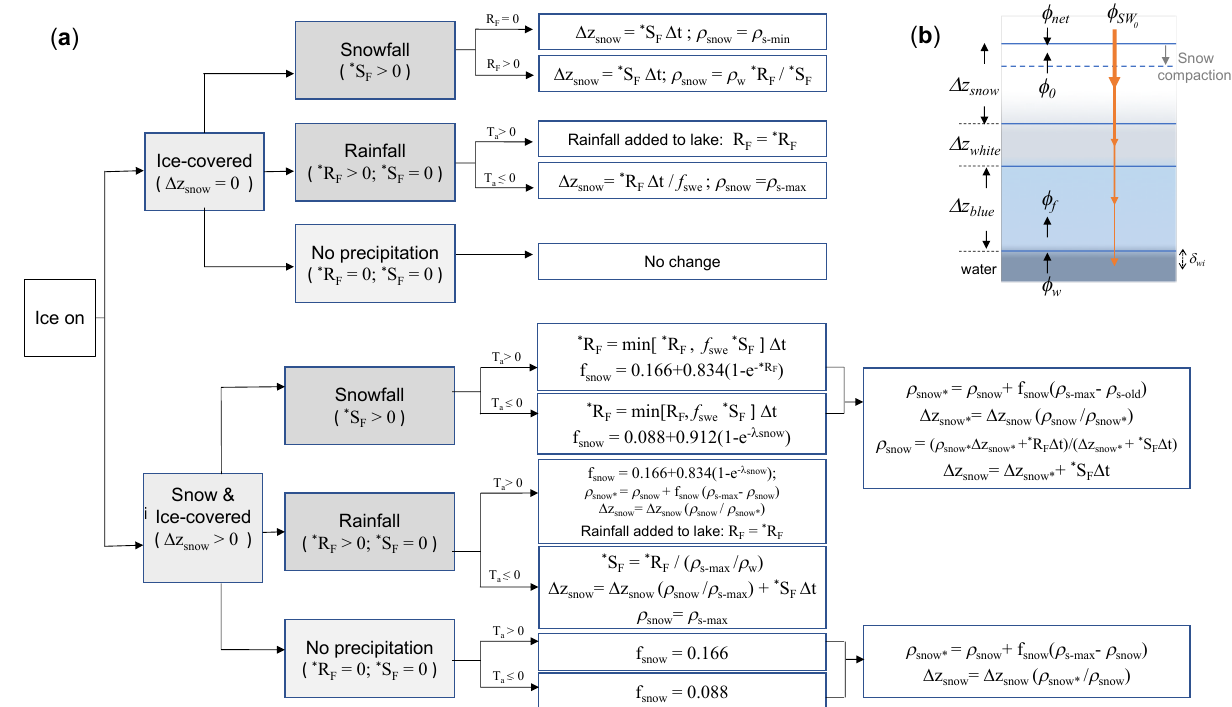
Figure 6. (a) Decision tree describing updates to the snow cover each time step according to the amount of incident rainfall ( ∗ R F ) and snowfall ( ∗ S F ), air temperature ( T a ), and snow compaction rules. (b) Schematic of ice and snow layers and heat fluxes. Refer to the text and Table 1 for definitions of other variables. Here, ∗ R F = f R R x /c secday and ∗ S F = f S S x /c secday if ice cover is present; otherwise they are set to 0 and the model reverts to Eqs.